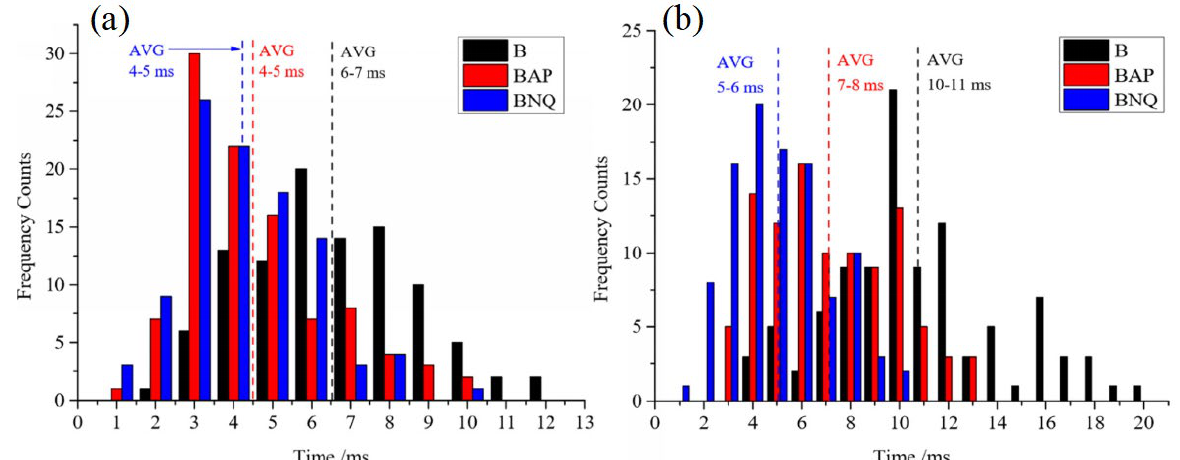
Figure 7. ( a ) Ignition time frequency counts and ( b ) combustion time frequency counts of different samples at 10 atm [71].